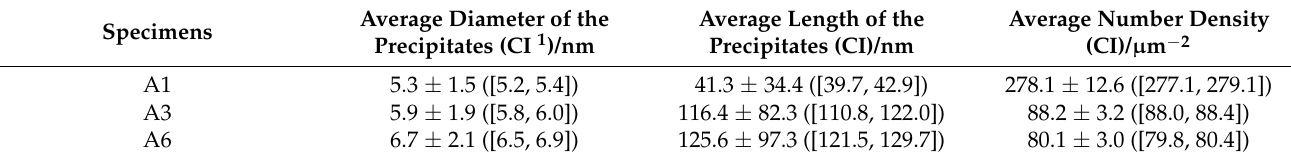
Figure 5. Transmission electron microscopy (TEM) images of the three investigated specimens: ( a ) A1, ( b ) A3 and ( c ) A6.